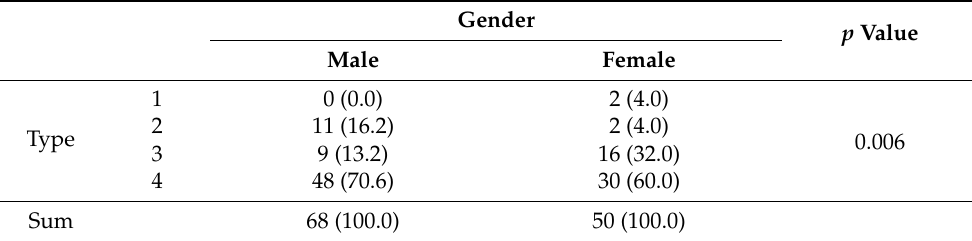
Table 4. Distribution of types according to the gender ( n = 118).